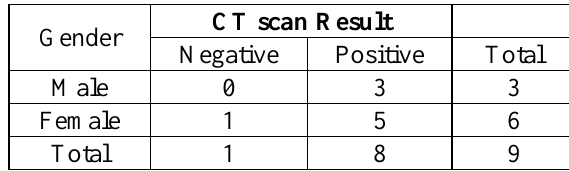
Table 5 : CT Scan result of 9 patients with positive cross over sign